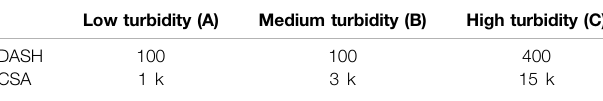
TABLE 1 | Photon counts (before correction) required at low SNR for comparable performance as in the noise-free case. Low turbidity